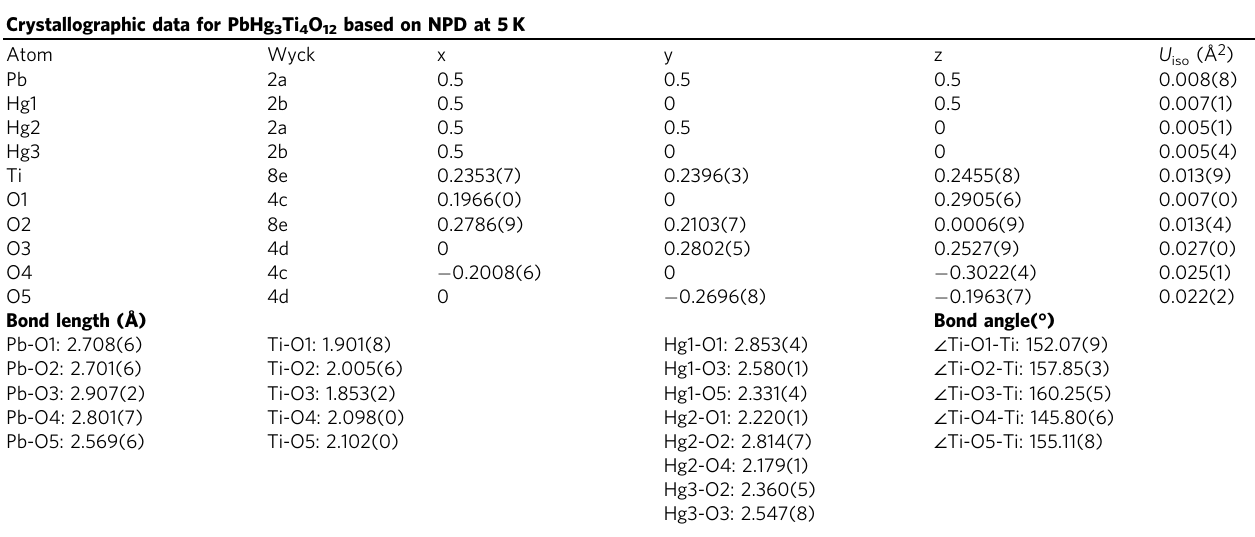
Table 3 Re fi ned structure parameters of PHTO based on NPD data collected at 5